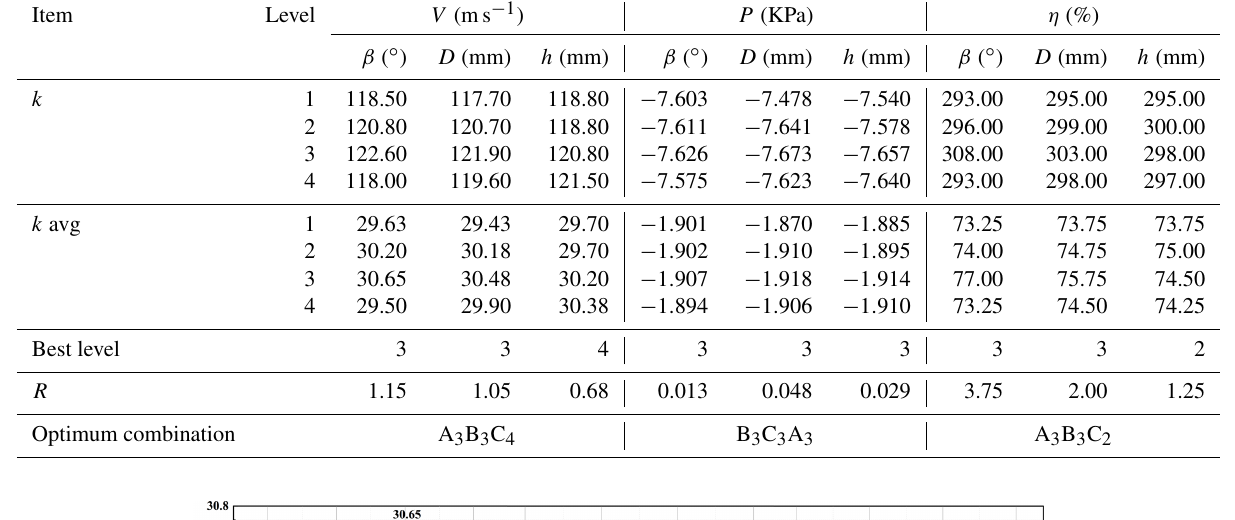
Table 4. Analysis of extreme deviations.